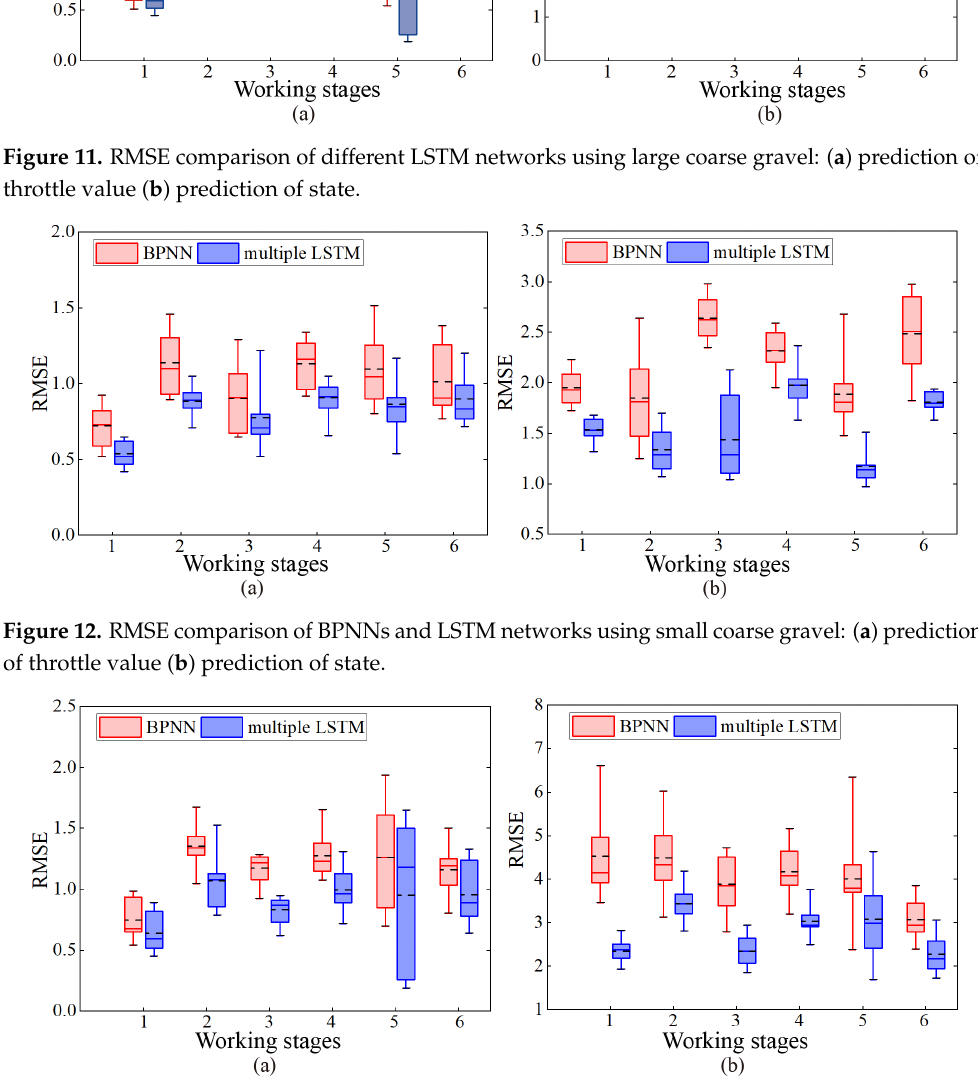
Figure 13. RMSE comparison of BPNNs and LSTM networks using large coarse gravel: ( a ) prediction of throttle value ( b ) prediction of